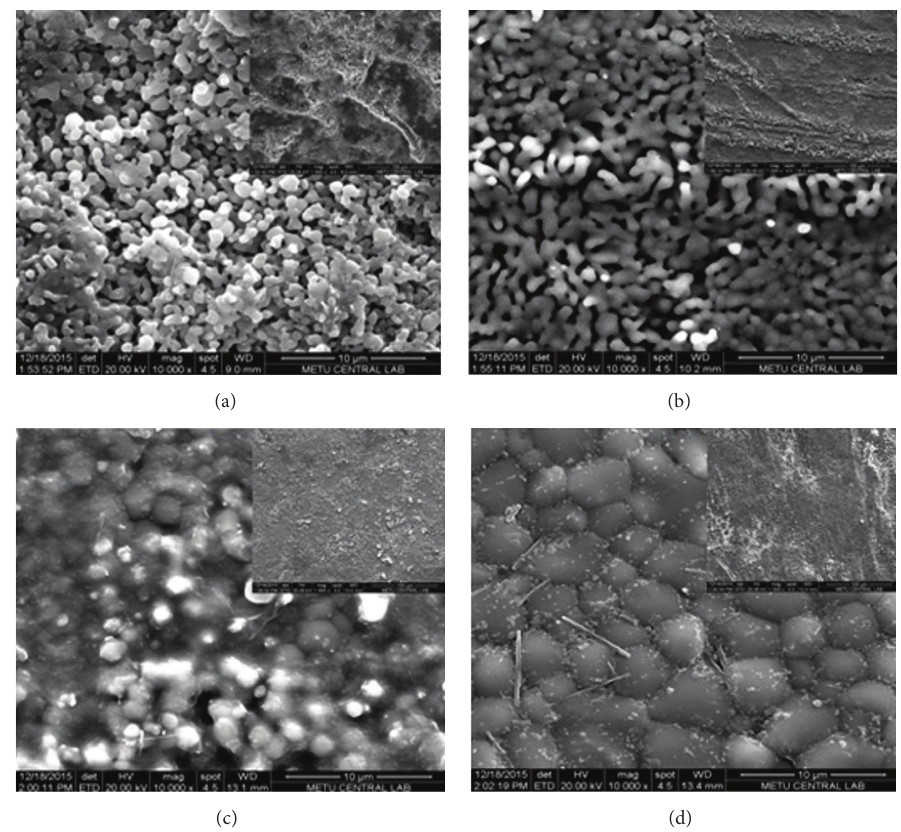
Figure 6: Microstructures of BHA samples sintered at (a) 1000 ∘ C, (b) 1100 ∘ C, (c) 1200 ∘ C, and (d) 1300 ∘ C at low ( × 1000, insets) and high ( × 10000, main images) magnifications.